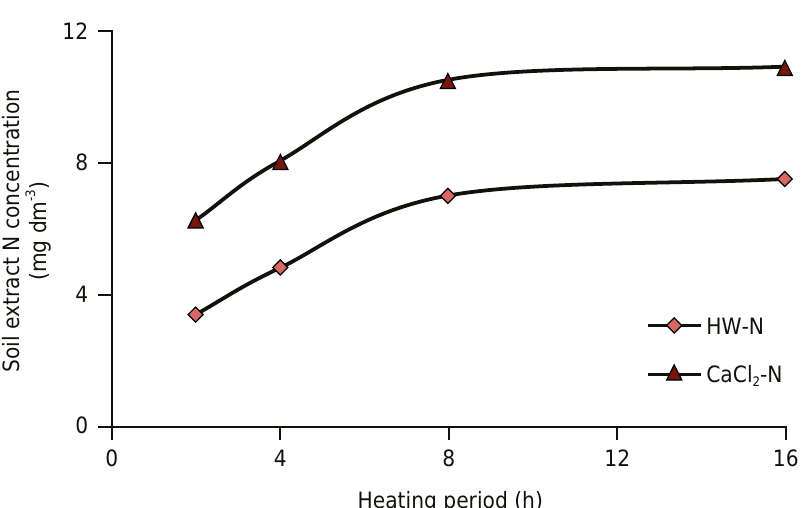
Figure 1. Average N concentrations in soil extracts of 17 soil samples using hot water (HW-N) and a hot solution of 0.01 mol L -1 CaCl 2 (CaCl 2 -N) under increasing heating periods (2, 4, 8, and 16 h heating periods).